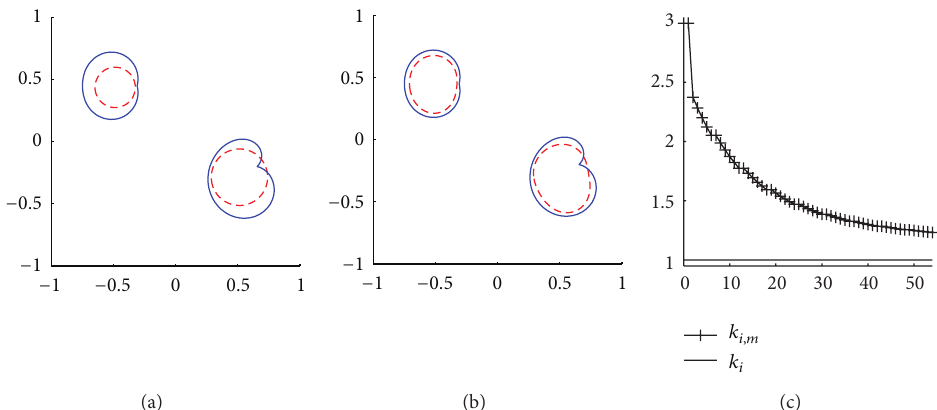
Figure 7: Reconstruction of objects with unknown 𝑘 𝑖 . (a) First guess of the objects. (b) Final reconstruction of the objects after nine updates of the domain (c) Values of 𝑘 𝑖 through the iterative